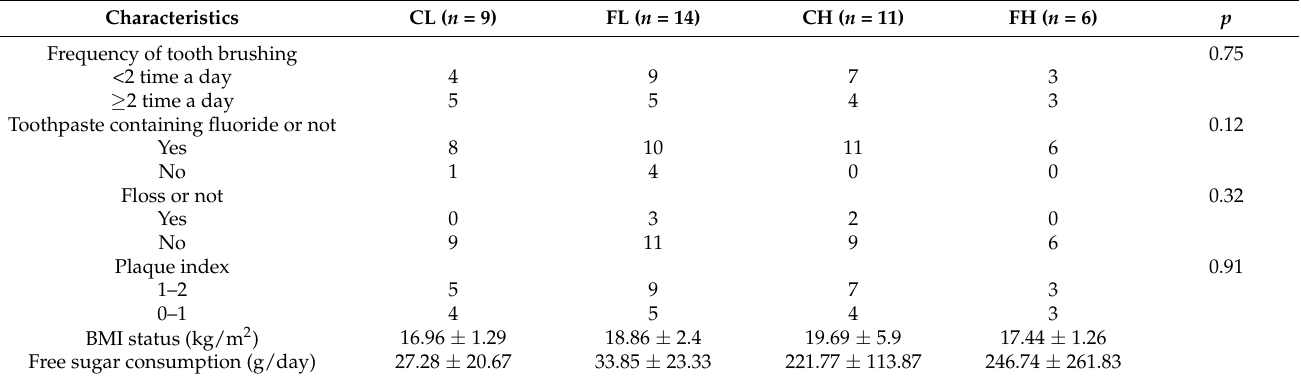
Table 1. Comparison of demographic variables and oral hygiene habits between groups.